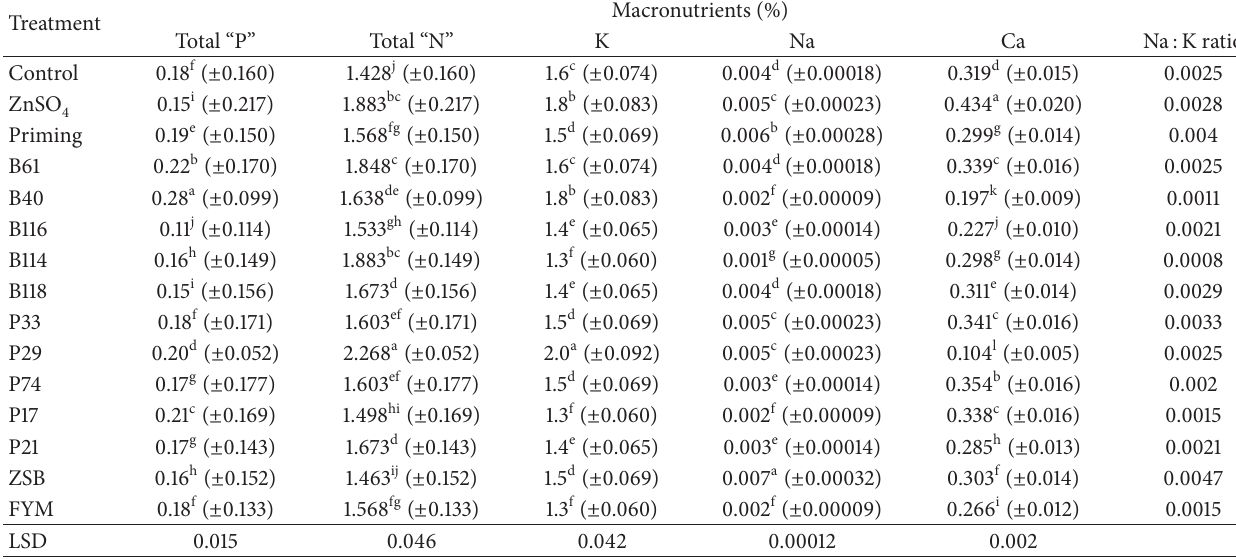
Table 3: Macronutrients uptake pattern of maize, seed treated with ZSBs, and inorganic source of zinc.